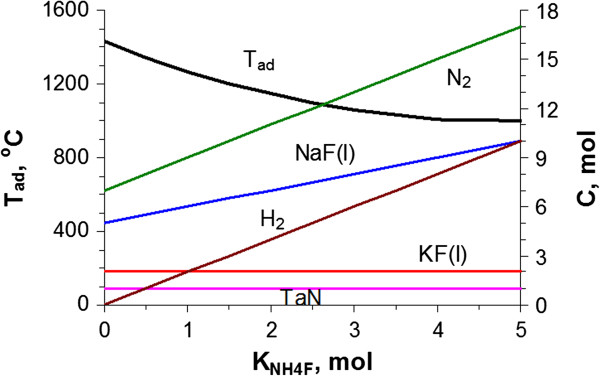
Tad and equilibrium phases in K2TaF7 + (5 + k)NaN3 + kNH4F system upon k.